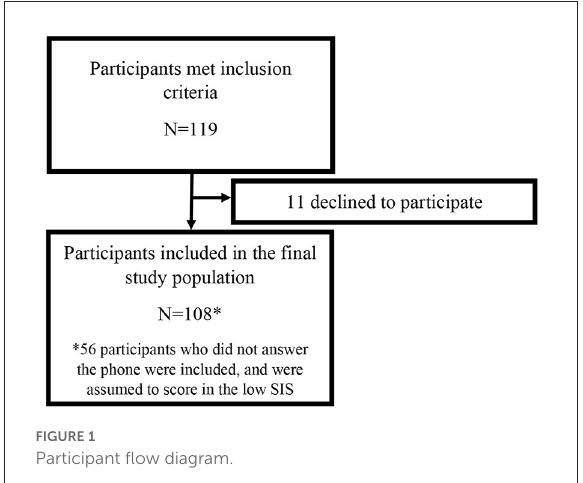
FIGURE1 Participant flow